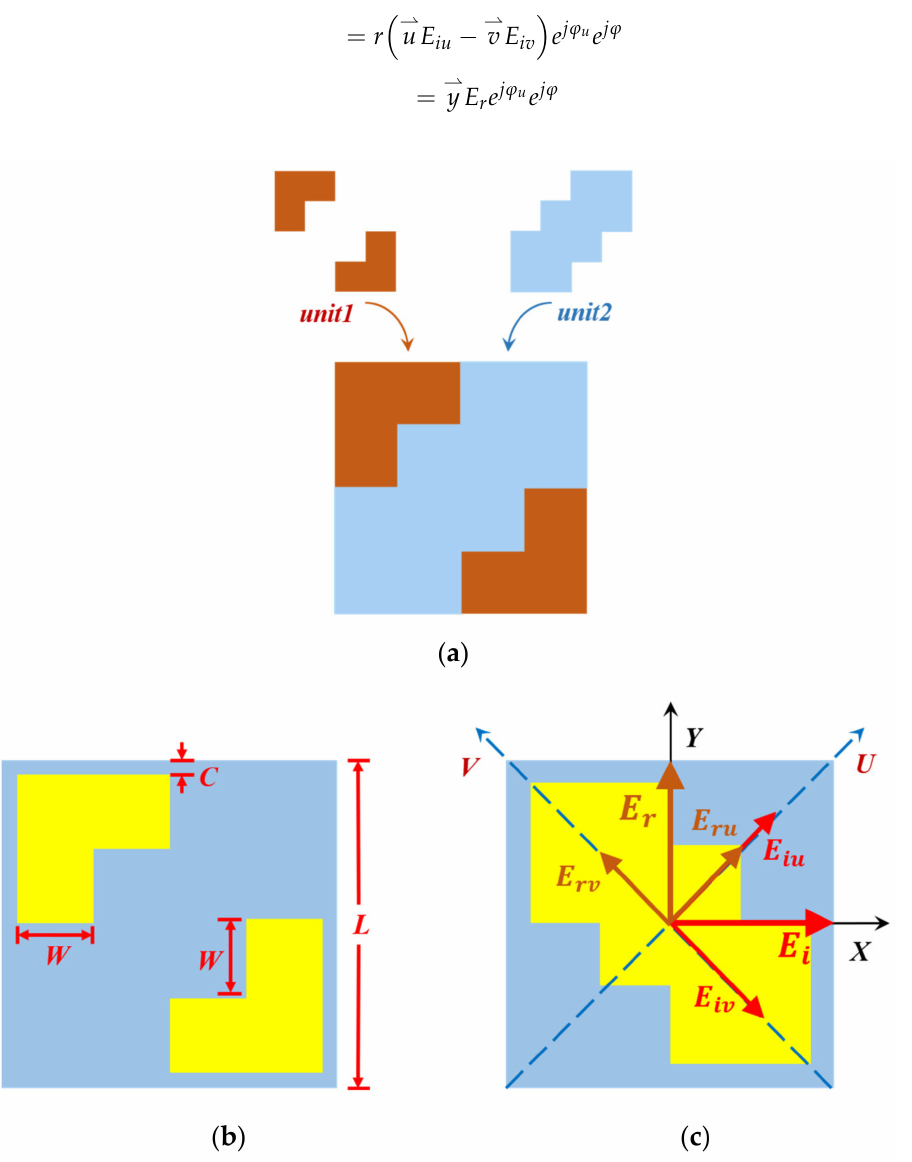
Figure 1. Polarization conversion unit design. ( a ) Complementary unit. ( b ) Structure of unit 1. ( c ) Structure of unit